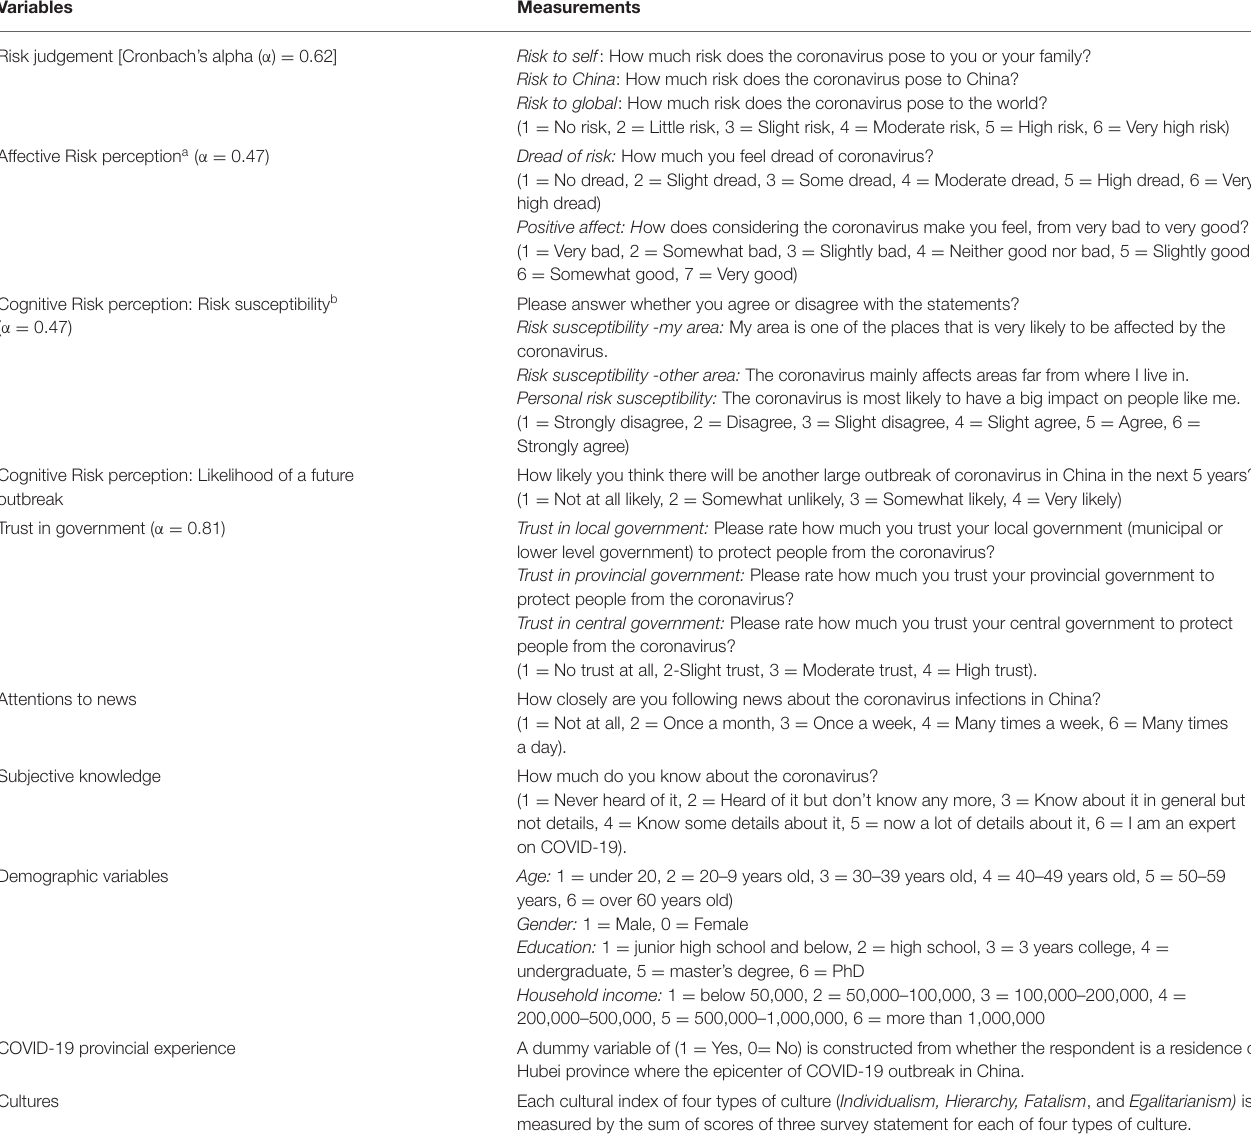
TABLE 1 | Measurements of dependent variables and survey of public reactions to coronavirus disease-2019 (COVID-19), China, 2020. Variables Measurements Risk judgement [Cronbach’s alpha ( α ) =